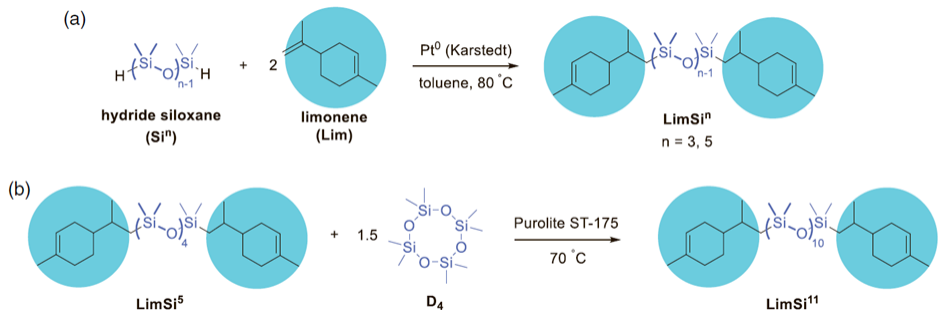
Figure 27. Synthesis of difunctional siloxane derivatives of limonene by hydrosilylation of the corresponding PDMS with functional Si–H groups ( a ) and by the ring-opening polymerization of octamethylcyclotetrasiloxane in the presence of a shorter difunctional siloxane derivative of limonene ( b ) (adapted with permission from Ref. [144]. 2019, Drozdov, F.V.).